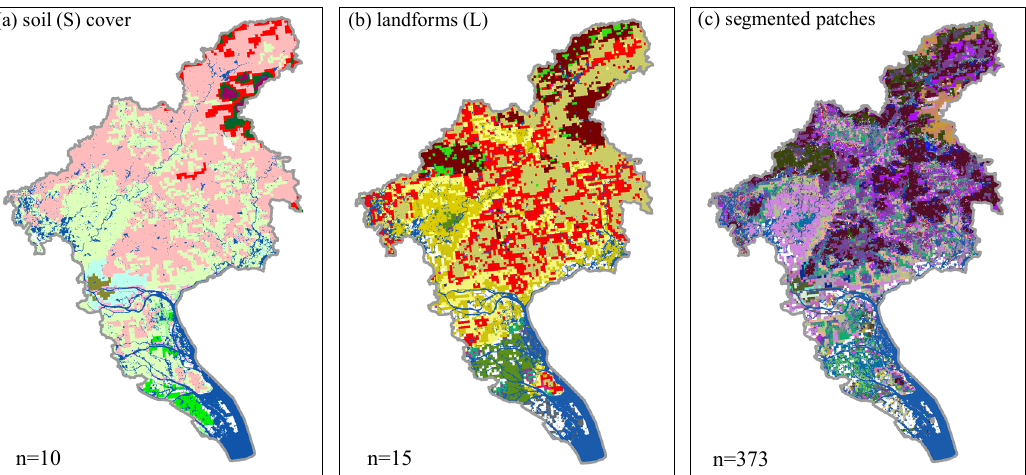
Figure 4. Soil (S) types: ( a ) landforms (L) ( b ) and the derived segmented patches ( c ) from S, vegetation (V) cover (refer to Figure 1c), and L. The colors in ( a , b ) show aggregation of the environmental factors (i.e., soil cover and landforms) and in ( c ) the homogeneous patches derived from the L, V, and S factors, where n in each figure indicates the numbers of classes.